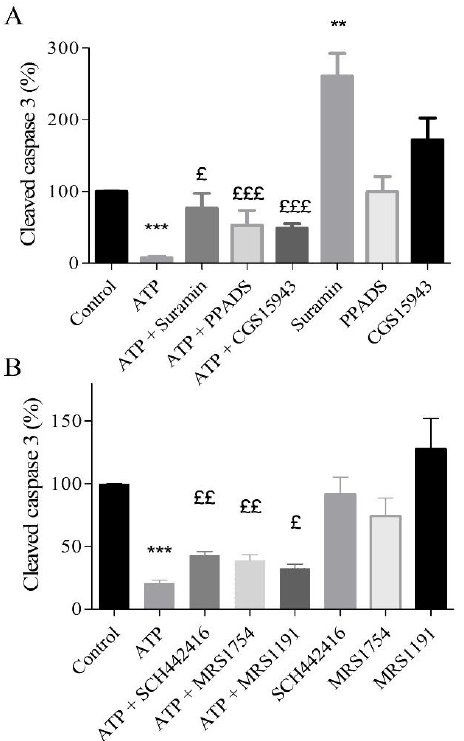
Figure 3. Anti-apoptotic effect of extracellular ATP mediated by both P2 and adenosine receptors ( A ). HUVECs, exposed to a simulated hypoxia during 2 hours, were treated with ATP 10 µM, P2